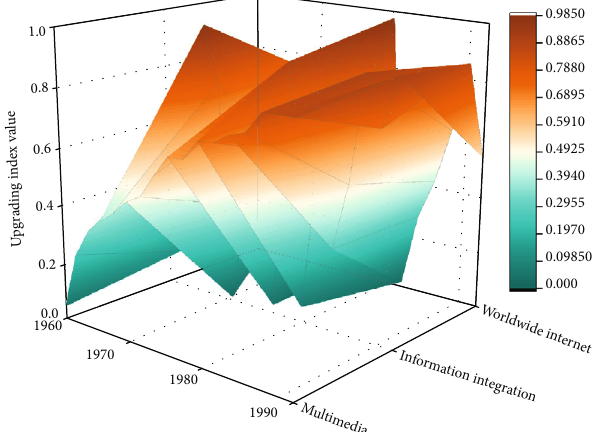
Figure 4: Changes in multimedia usage information during 1960- 1992.